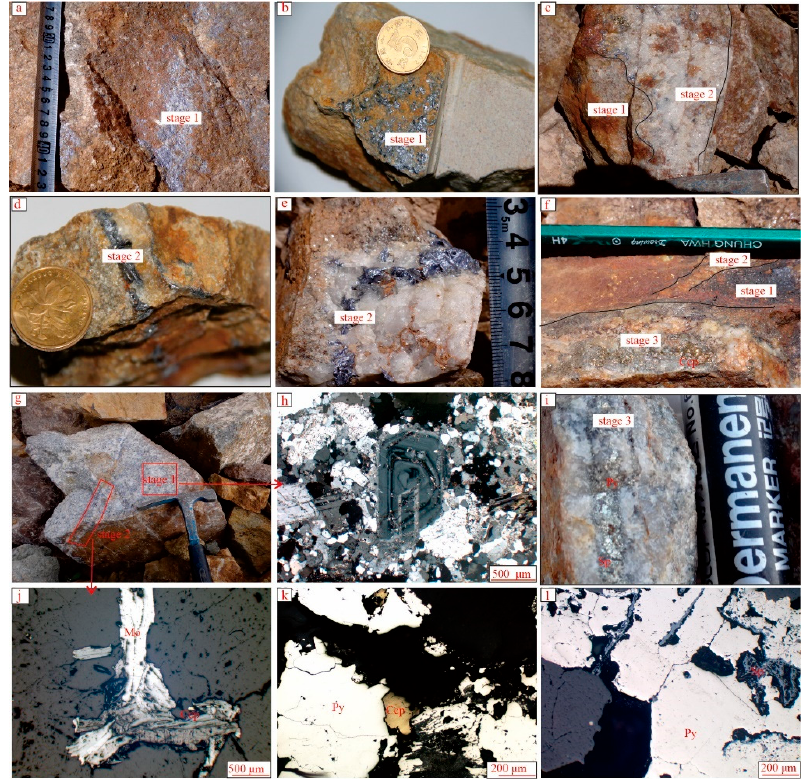
Figure 3. Representative field photos and photomicrographs of ore rocks. ( a , b ) Disseminated ore structure in stage 1; ( c ) quartz–molybdenite in stage 2; ( d , e ) molybdenite vein structure; ( f ) banded structures of molybdenite, pyrite and chalcopyrite in stage 3; ( g ) stage 1 and stage 2 relationship; ( h ) photomicrograph of mineralization of granite; (i) photos of mineralization of stage 3; ( j ) photomicrographs of mineralization of stage 2; ( k , l ) photomicrographs of mineralization of stage 3; Ccp—chalcopyrite; Mo—molybdenite; Py—pyrite.